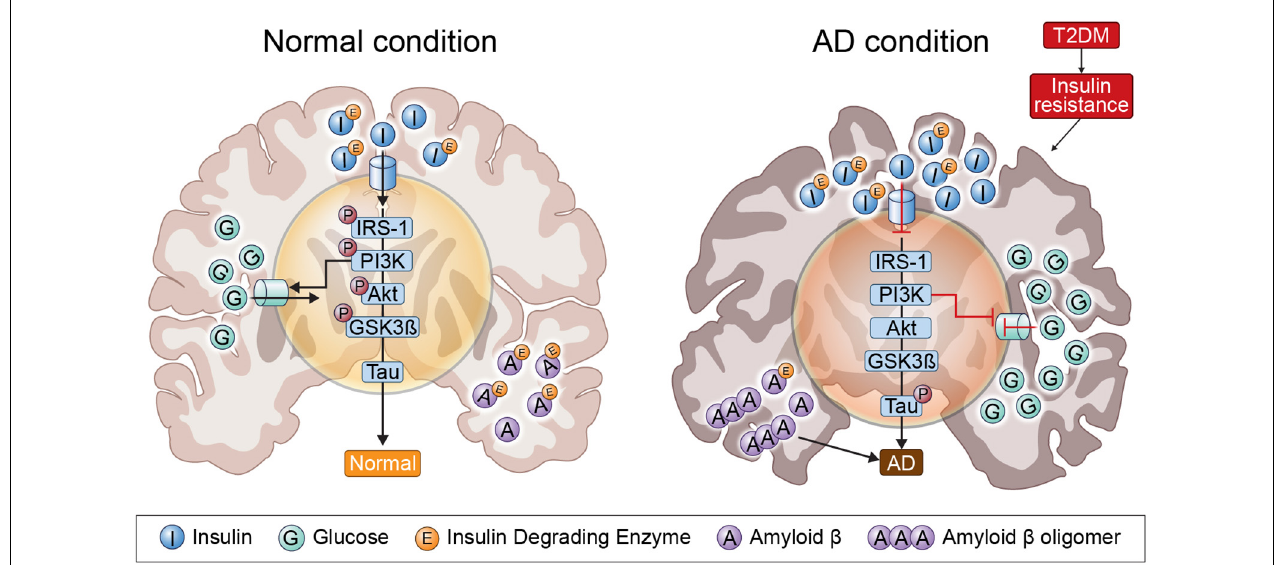
FIGURE 1 | Insulin signaling in the normal condition brain and AD brain. In insulin-resistant state induced by T2DM, as insulin signaling is impaired, insulin is unable to bind to an insulin receptor, and multiple tyrosine residues are not auto-phosphorylated to activate insulin receptor substrate 1, which mediates downstream signaling through phosphoinositide 3-kinase. Therefore, GSK3- β is overactivated and tau is